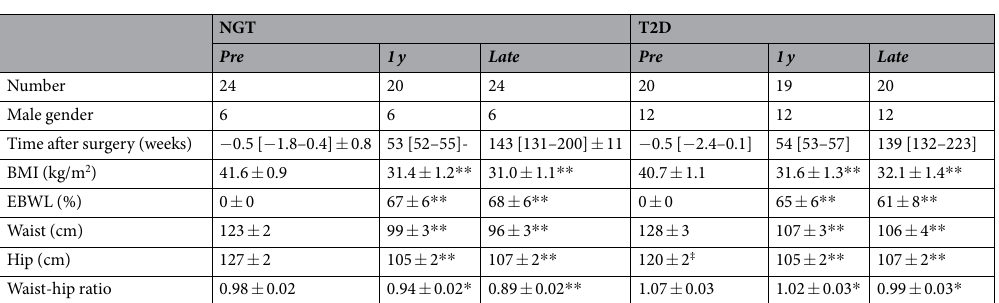
Table 3. Weight and biometrics. * p < 0.05 vs pre; ** p < 0.001 vs pre; † p < 0.05 vs 1 y; ‡ p < 0.05 vs NGT at corresponding time point. All parameters are mean ± SEM, except time after surgery, which is Median [IQR].